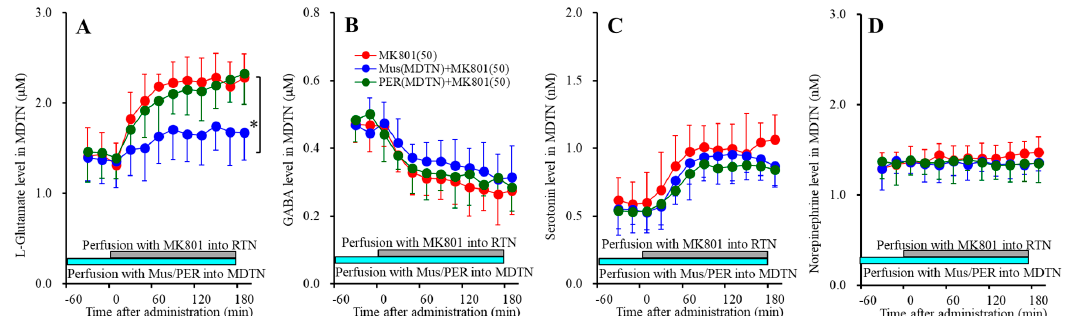
Figure 5. Effects of local administration of muscimol and perampanel into the MDTN on 50 μ M RTN MK801-induced releases of L -glutamate ( A ), GABA ( B ), serotonin ( C ), and norepinephrine ( D ) in the MDTN (Study_3). Ordinates: mean ± SD ( n = 6) of extracellular transmitter levels ( μ M or nM); abscissa: time after MK801 administration (min). Light blue bars indicate perfusion with 1 µ M muscimol (Mus) or perampanel (PER) into the MDTN. Gray bars indicate the perfusion with 50 µ M MK801 into the RTN. * p < 0.05; relative to control (50 µ M MK801) by MANOVA with Tukey’s post hoc